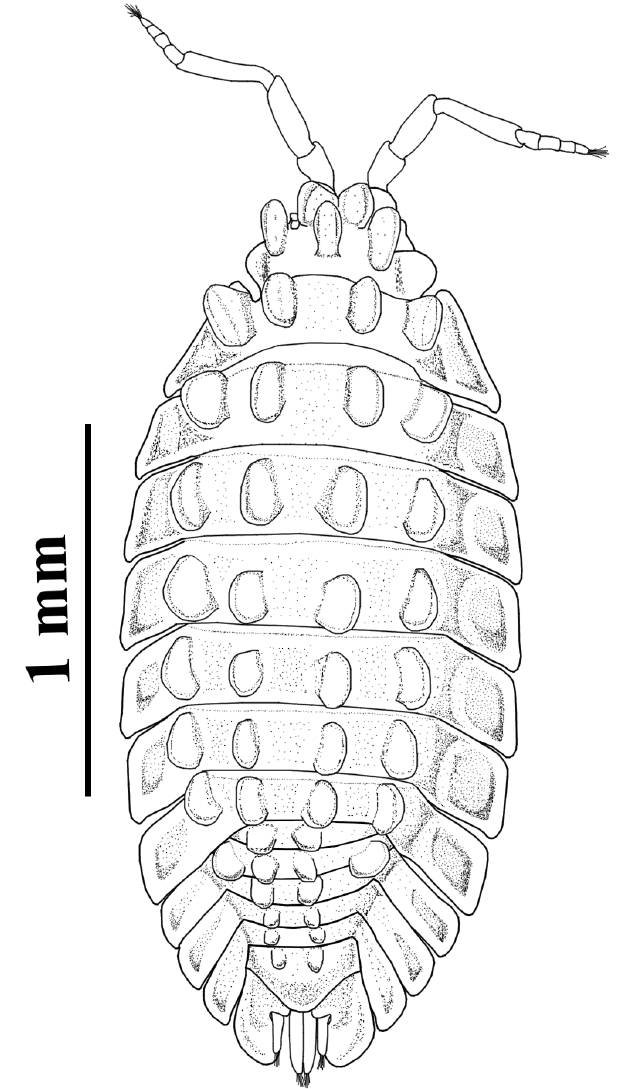
Fig. 9. Armadilloniscus caraibicus Paoletti & Stinner, 1989, ♂ (CUDC-CRU 190). Habitus, dorsal